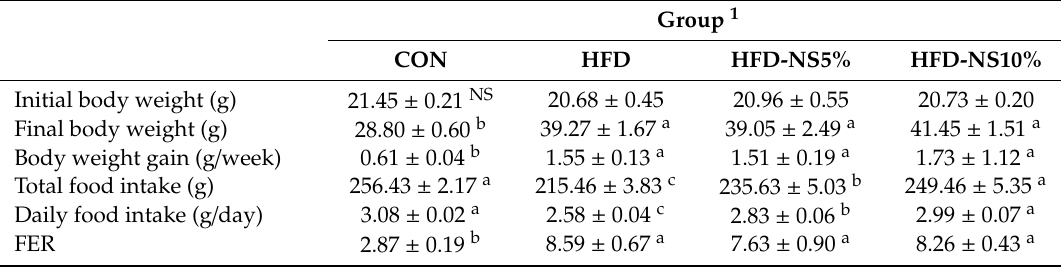
Table 2. E ff ect of Nelumbinis Semen powder on body weight gain, food intake, and FER ( n = 8 / group). Group 1 CON HFD HFD-NS5% HFD-NS10% Initial body weight